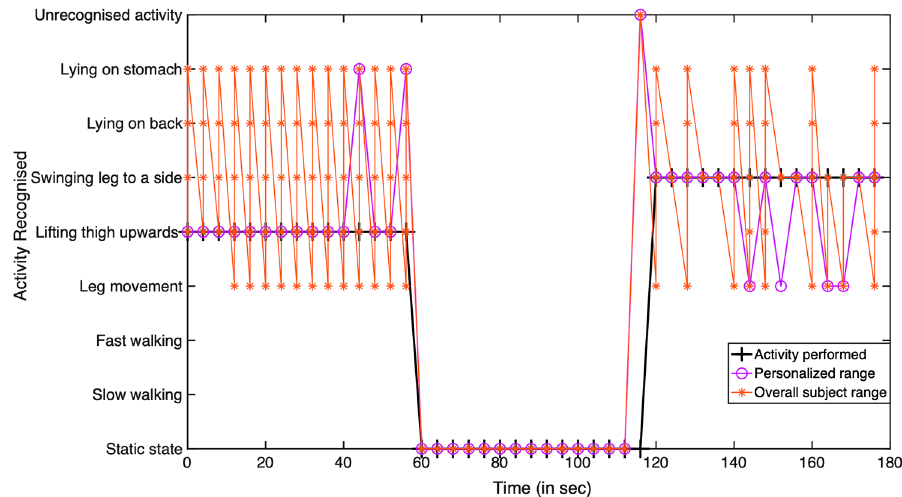
Figure 5 . Long-term group-based activity performed (LTU, static and SLTS) recognition accuracy comparative analysis with respect to personalized and overall subject ranges.